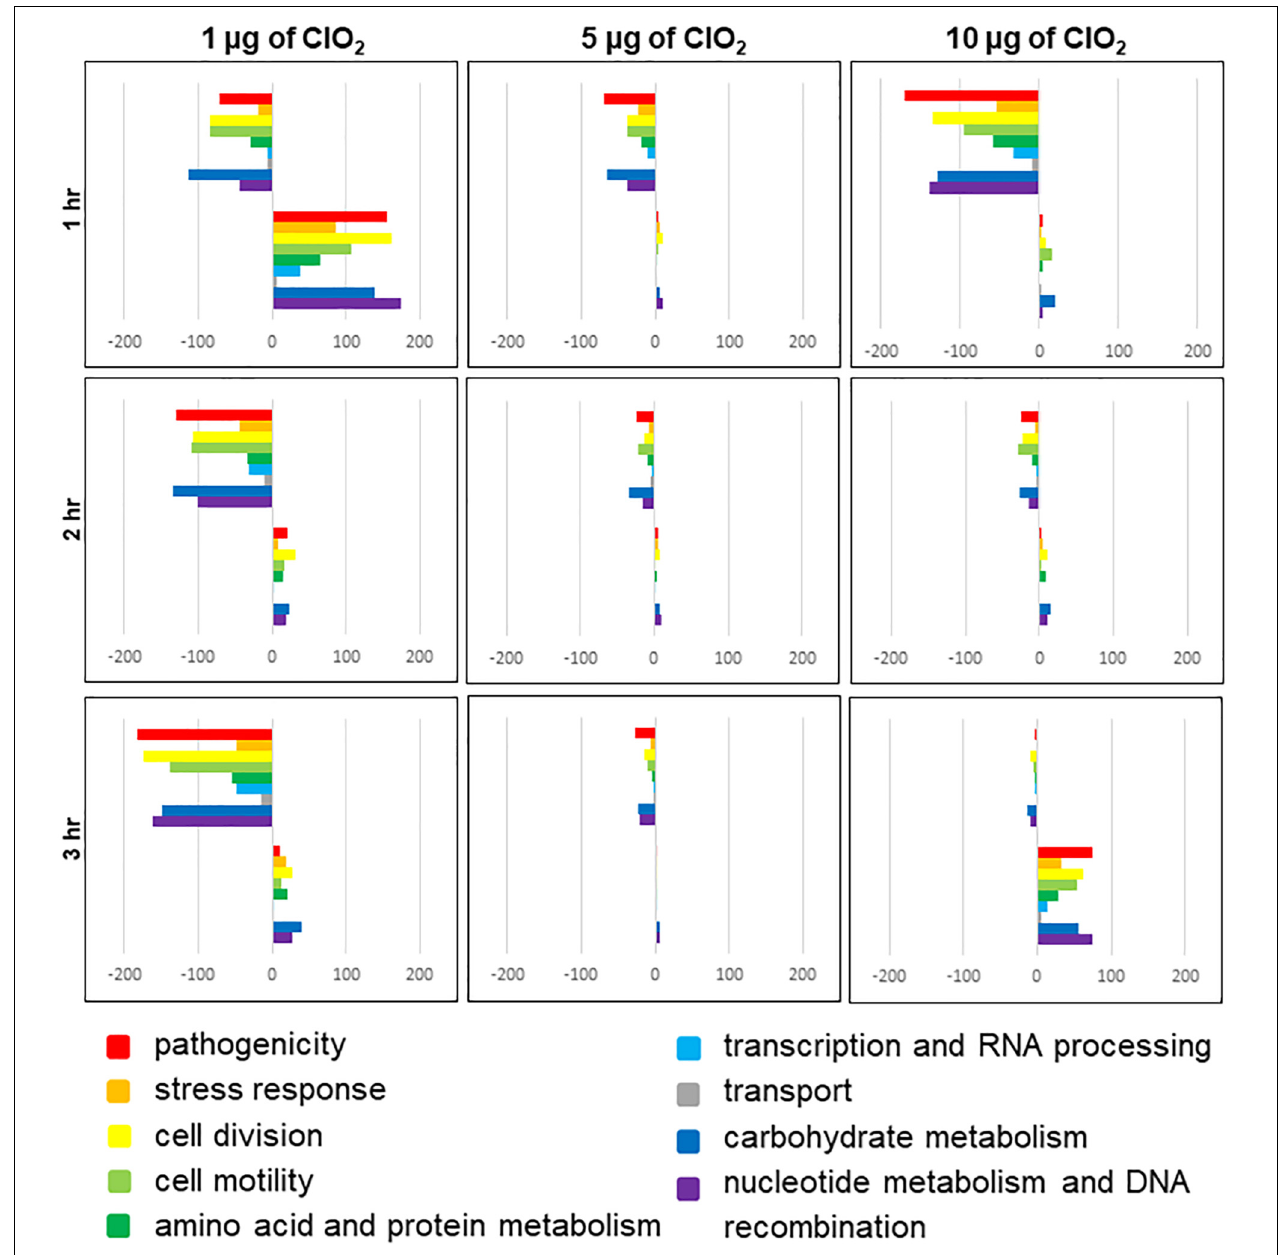
FIGURE 3 | Functional categories of E. coli genes that are differentially regulated by ClO 2 treatments after 1 h, 2 h, and 3 h exposure. Colored bars represent the number of regulated genes assigned to functional categories. Positive bars denote the number of upregulated genes. Negative bars denote number of downregulated genes. Genes assigned to ‘other category’ and ‘unknown’ are not included in this figure.